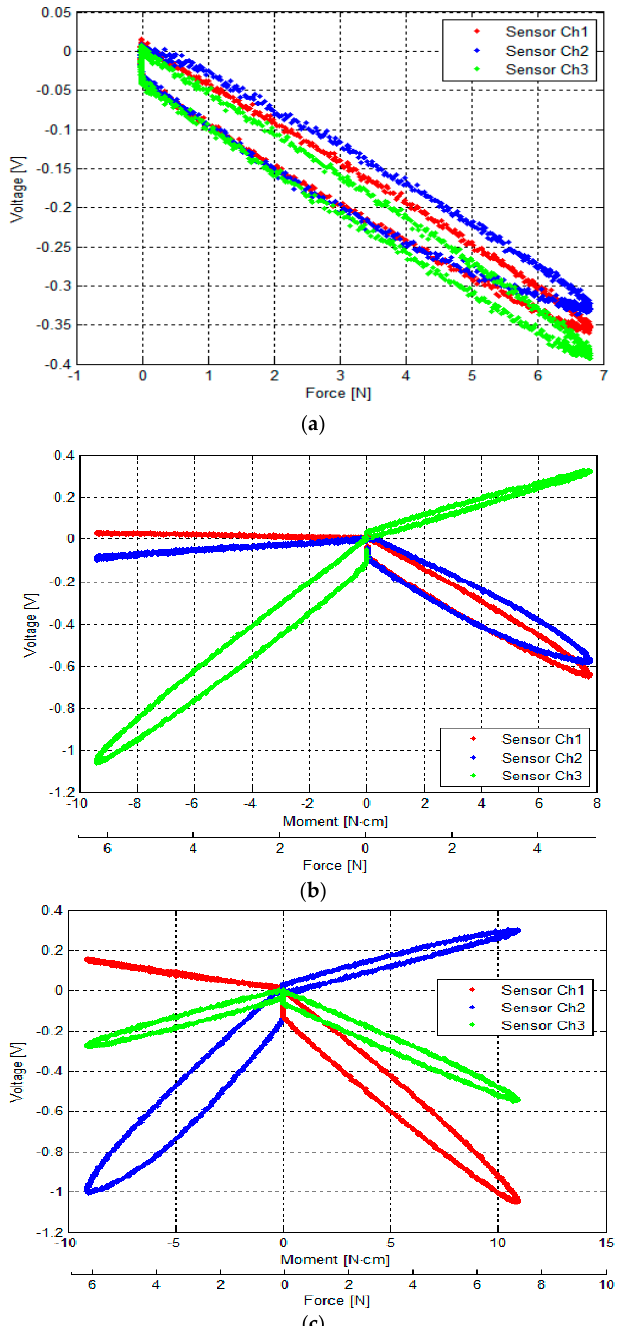
Figure 13. Characteristic curves between the physical loads (force/moment) and the output voltage of the force sensor: ( a ) Between the load ( F z ) and the output voltages of the force sensor: external force was applied to and released from point ⓪ by the sensor calibration device as shown in Figure 12b; ( b ) between the loads ( F z , M x ) and the output voltage of the force sensor: external force was applied to and released from points ① and ② ; and ( c ) between the loads ( F z , M y ) and the output voltage of the force sensor: External force was applied to and released from points ③ and ④ .